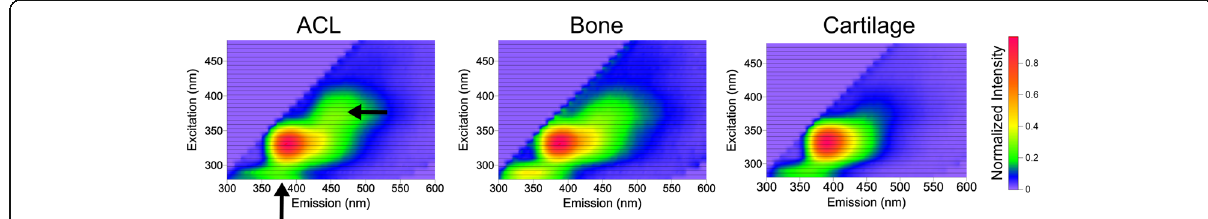
Fig. 1 Typical 3D excitation-emission maps normalized to the peak intensity of insertion site (ACL), bone and cartilage from one bovine knee. Note the differences in autofluorescent response between the separate components indicated by